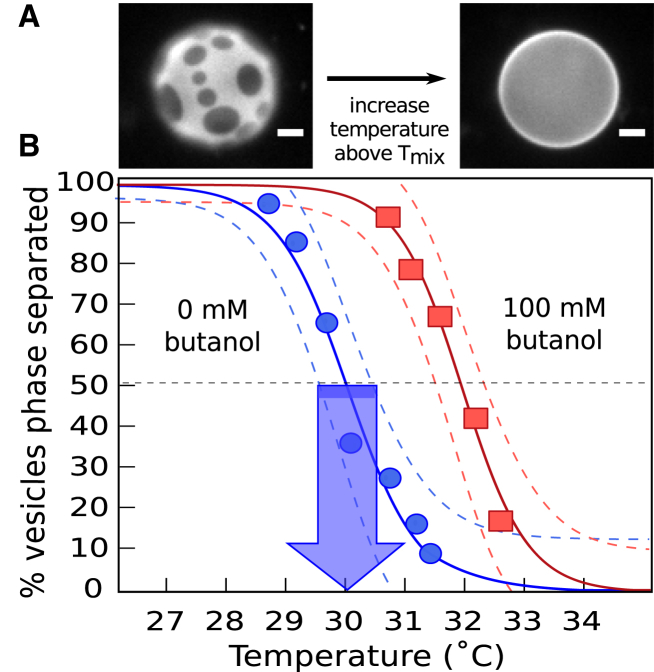
(A) Left: Below Tmix, 35/35/30 DOPC/DPPC/cholesterol vesicles exhibit domains of Lo (dark) and Ld (bright) phases. In taut vesicles, domains merge until only one domain of each phase remains (34). Right: Above Tmix, all lipids mix uniformly. Scale bars represent 20 μm. (B) Tmix is higher for 35/35/30 DOPC/DPPC/cholesterol vesicles in 100 mM butanol (squares, Tmix = 32.3 ± 0.19°C) than in pure water (circles, Tmix = 30.4 ± 0.29°C). Each point records the percent of vesicles with coexisting Lo and Ld phases at a given temperature. Dashed lines are 95% confidence intervals (13). The arrow points to Tmix for the left curve; the width of the arrow’s base is the uncertainty. To see this figure in color, go online.